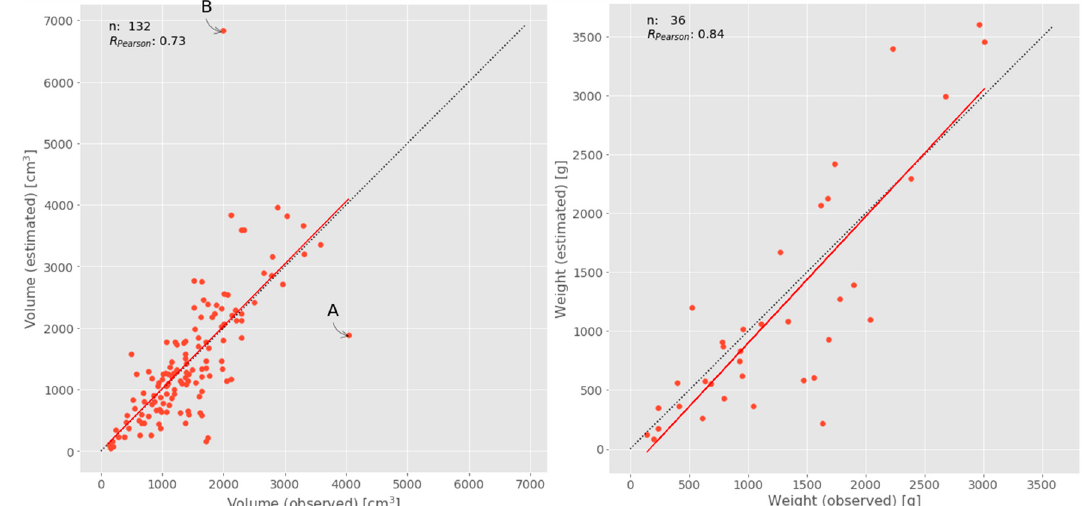
Figure 7. Scatterplot of observed and estimated fruit volume (left) and weight (right) with 1:1-line (gray) and correlation (red).